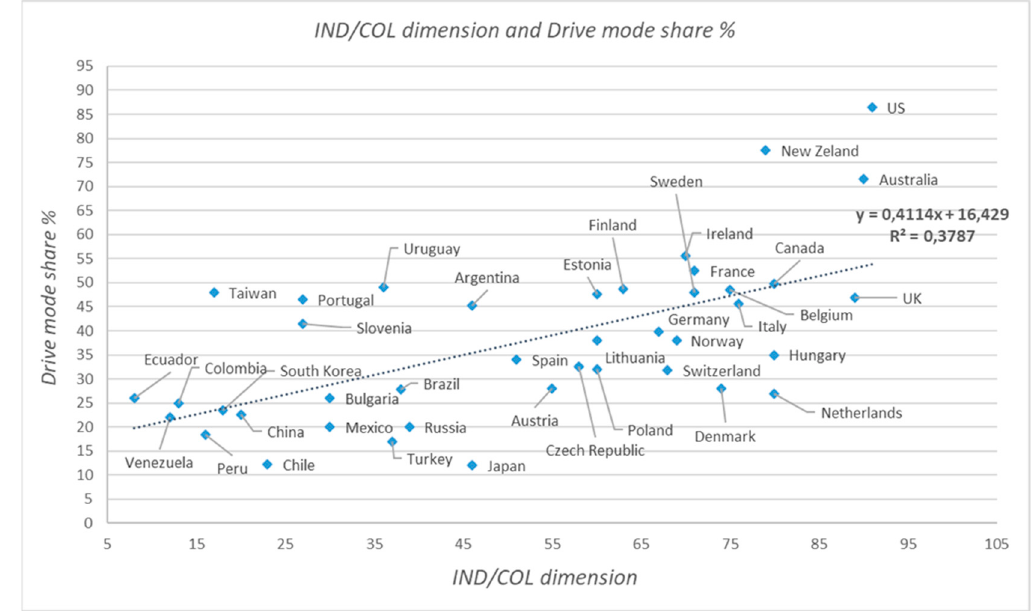
Figure 2. Drive mode share over individualism-collectivism dimension.